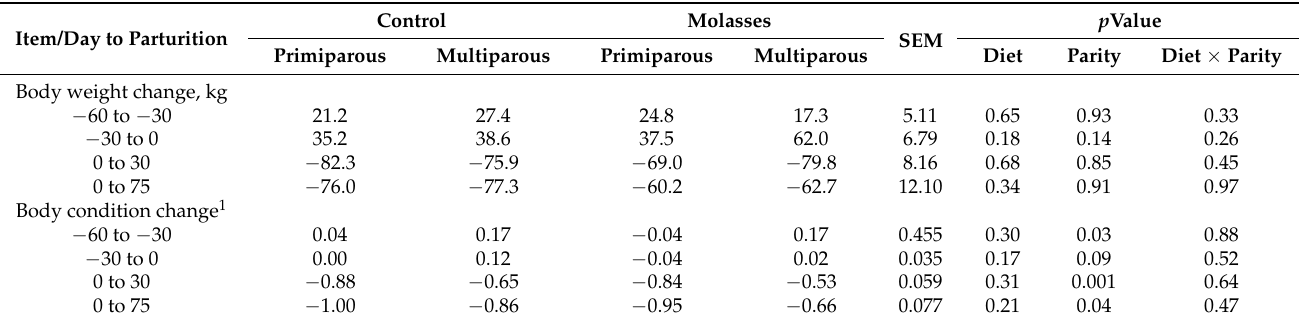
Table 5. Prepartum and postpartum BW change and BCS change for primiparous and multiparous cows fed control or molasses diets during a 60 day dry period (Experiment 1).